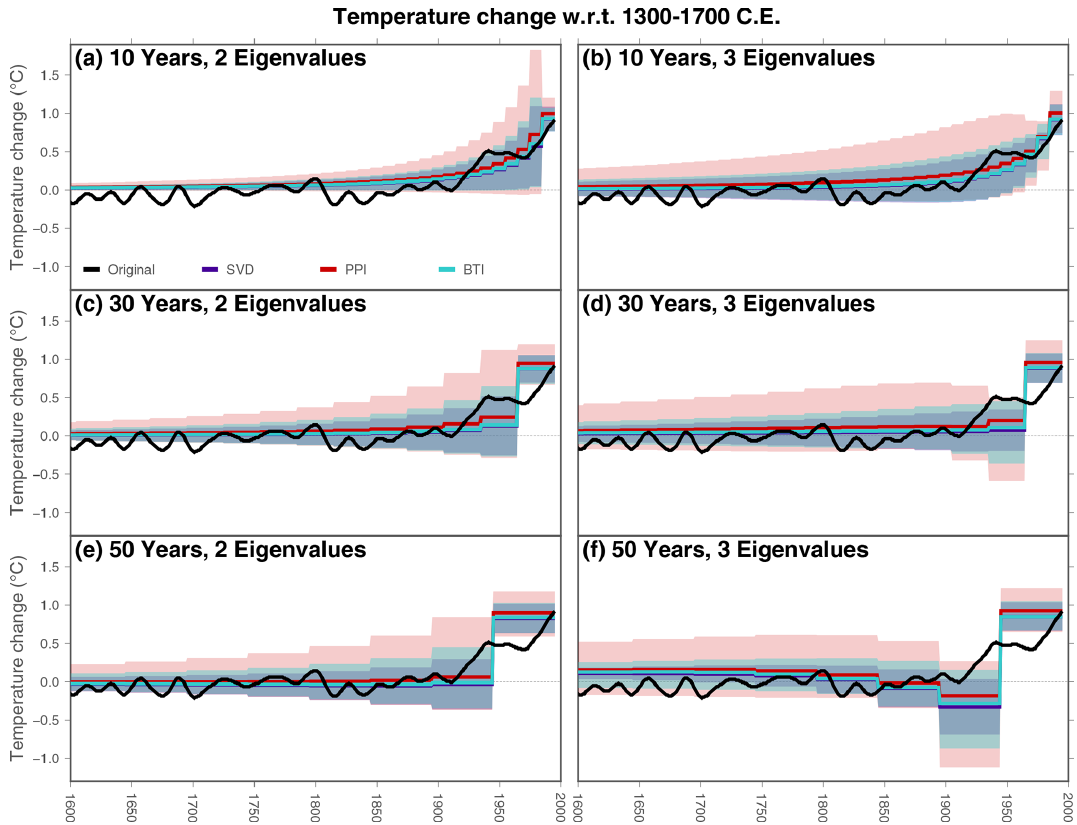
Figure 3. Ground surface temperature histories from the artificial profile using different step lengths for retrieving the surface signal (rows) and retaining different number of eigenvalues (columns). Colors indicate the method employed for the estimates: SVD (purple), PPI (red), and BTI (light blue). BTI results are derived using a Sampling ensemble of one member (the artificial profile) and a Bootstrapping ensemble of 1000 members. Shadows indicate the uncertainty range for each method. The original surface signal is represented in